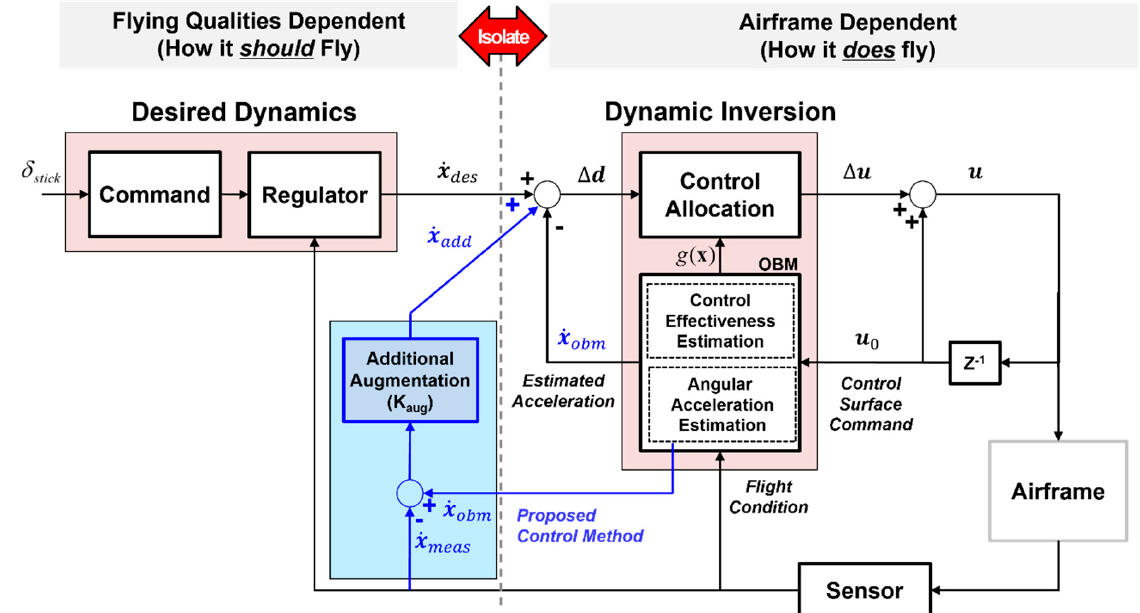
Figure 2. Control structure of the INDI control including the model-based, sensor-based, and additional augmentation control design concepts.